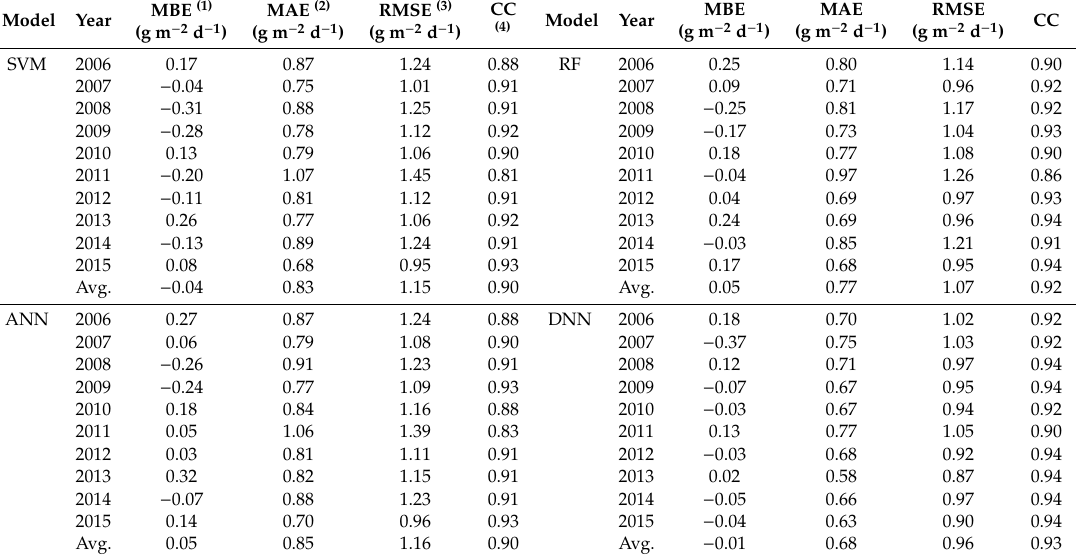
Table 4. Validation statistics of daily gross primary productivity (GPP) at the Gwangneung site for the period between 2006 and 2015, predicted by support vector machine (SVM), random forest (RF), artificial neural network (ANN), and deep neural network (DNN).